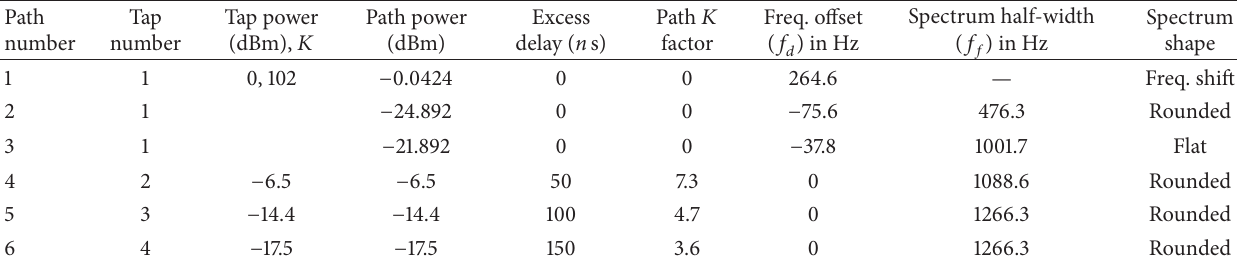
Table 1: Six-path OFDM channel